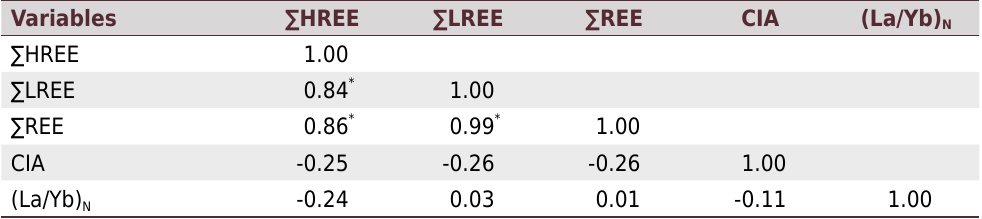
Table 2. Pearson correlation coefficients among ∑HREE, ∑LREE, ∑REE, and CIA values in soils developed from different geological settings of Rio Grande do Norte, Brazil (n = 104 soil samples) Variables